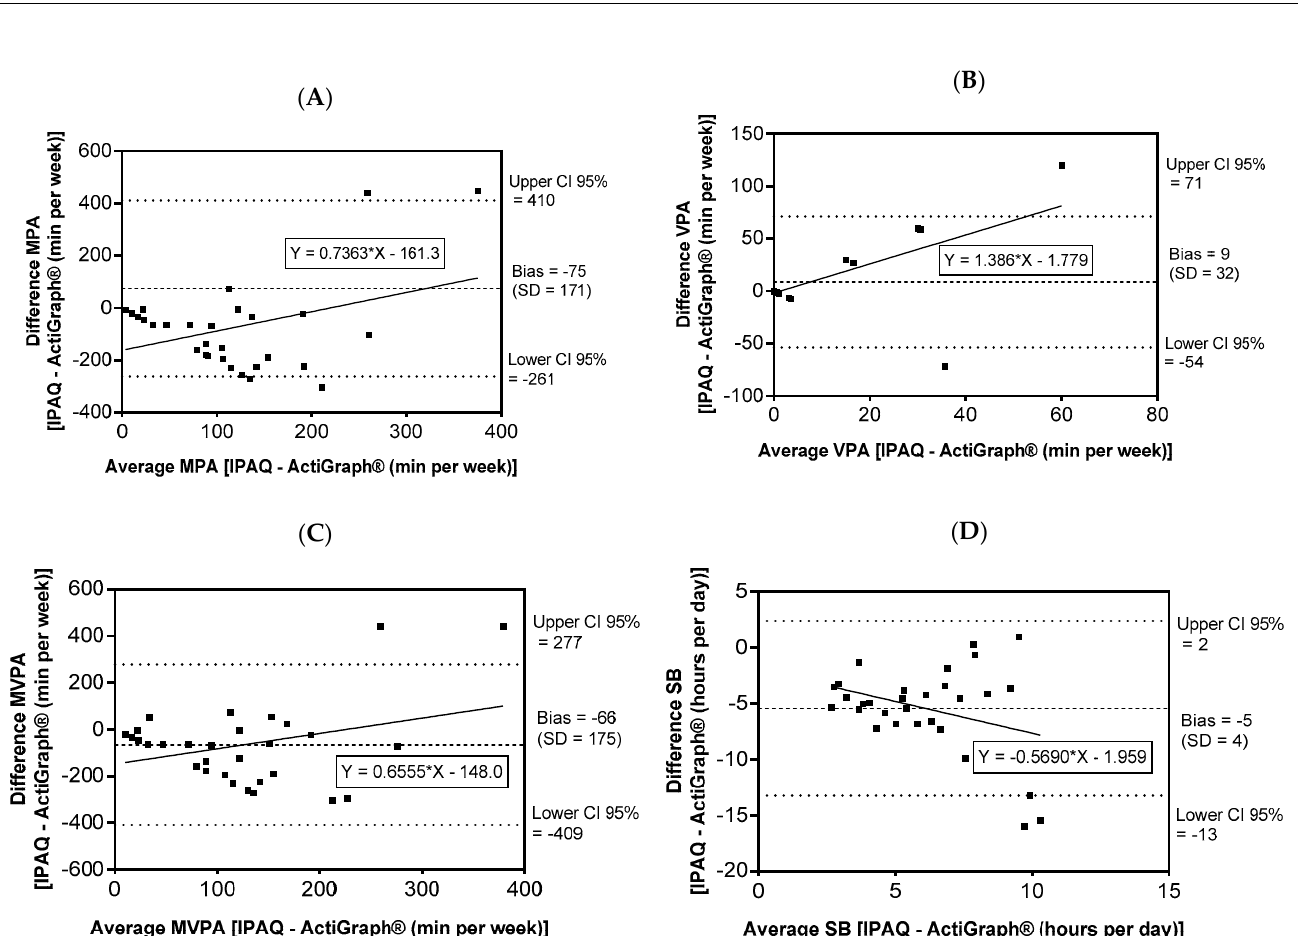
Figure 3. Bland–Altman graphs of people with major depressive disorder or bipolar disorder with measurements obtained by IPAQ and ActiGraph ® . The x-axis (mean of the measurements obtained by IPAQ and ActiGraph ® ) and y-axis (difference in the measurements obtained by IPAQ and ActiGraph ® ). The bias, standard deviation (SD), and 95% confidence interval (CI) of the differences are presented as a linear regression (with an equation). Panel ( A ) = moderate physical activity (MPA); Panel ( B ) = vigorous physical activity (VPA); Panel ( C ) = moderate and vigorous physical activity (MVPA); Panel ( D ) = sedentary behavior (SB).